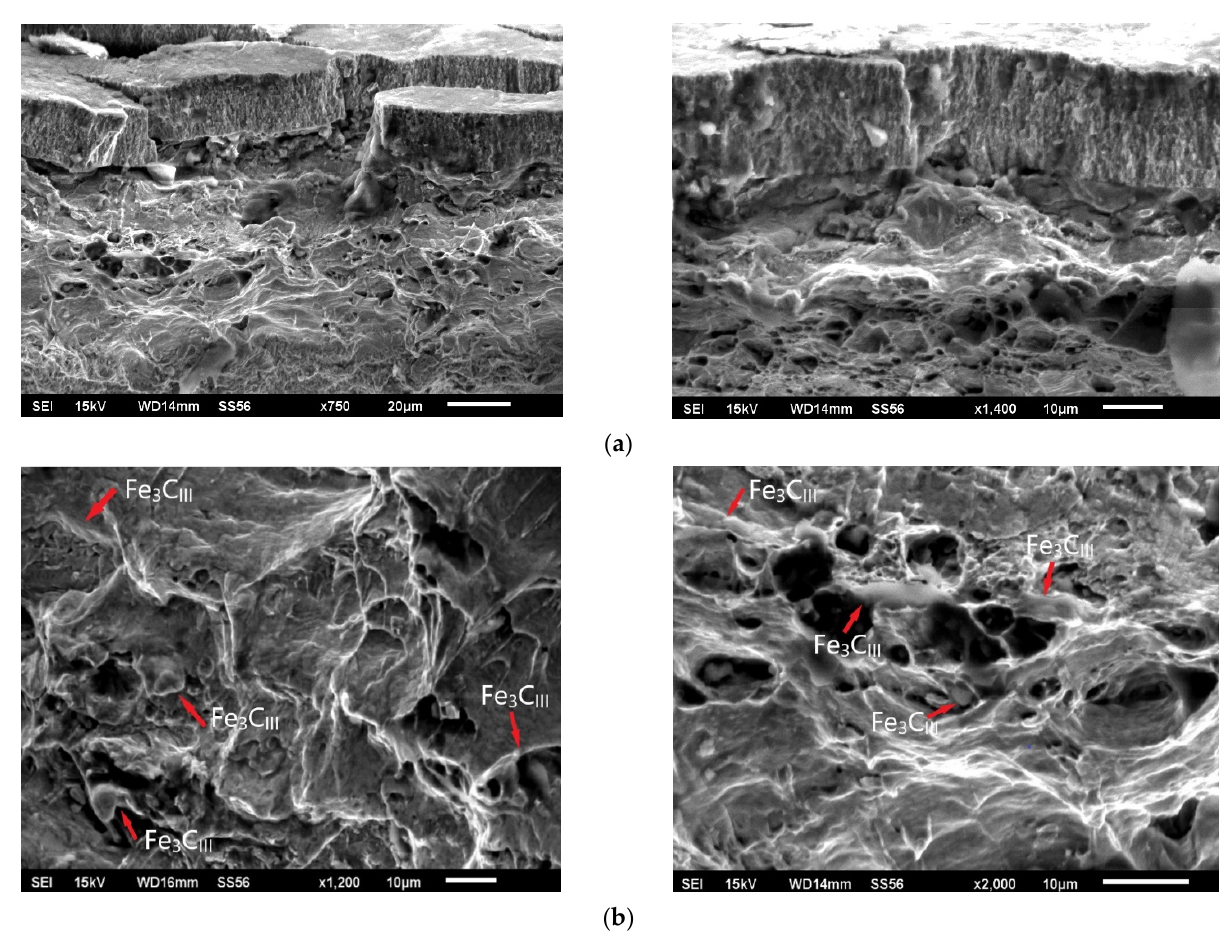
Figure 13. SEM image of rivet fracture after forming process, ( a ) surface of rivet flange ( b ) fracture structure with visible tertiary cementite (Fe 3 C III ) phase (red markers).